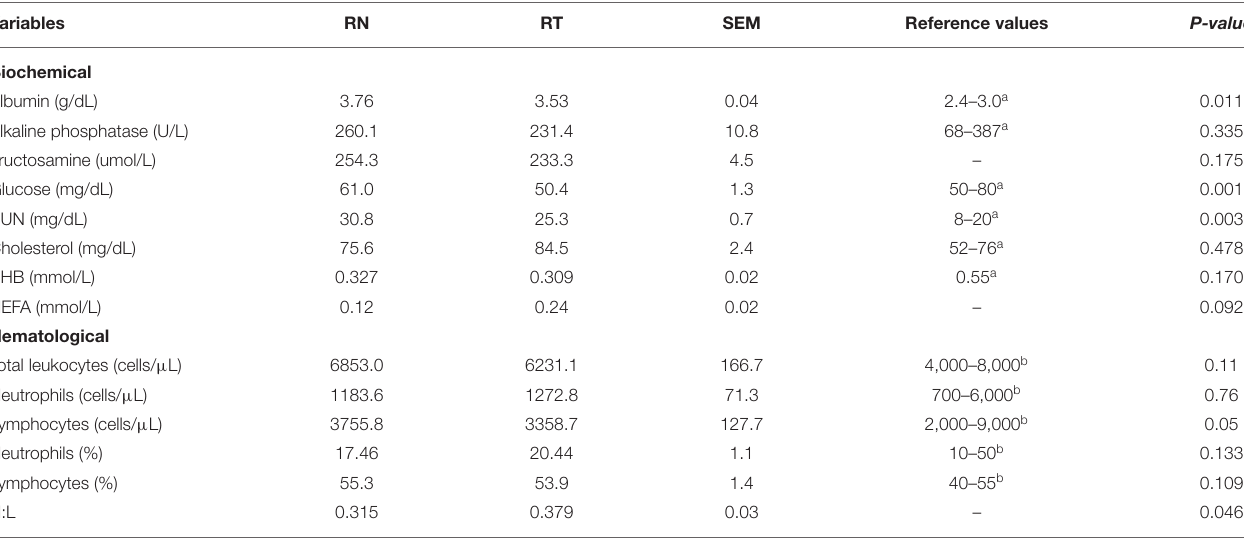
TABLE 4 | Biochemical and hematological parameters of sheep grazing vegetative Italian ryegrass pastures under contrasting grazing management strategies (RN and RT) in rotational stocking. Variables